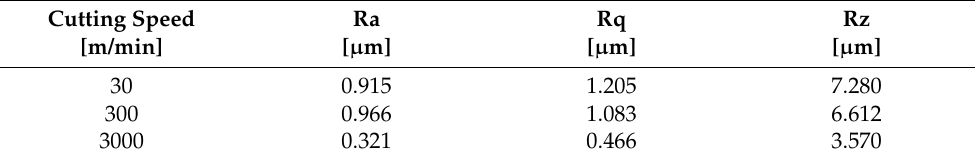
Table 7. Recorded values of surface roughness after machining of zirconia.